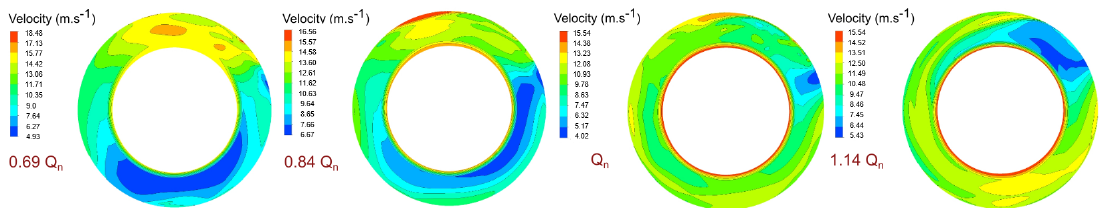
Figure 10. Velocity in the middle section of the front pump sidewall gap for off-design and nominal flow rate